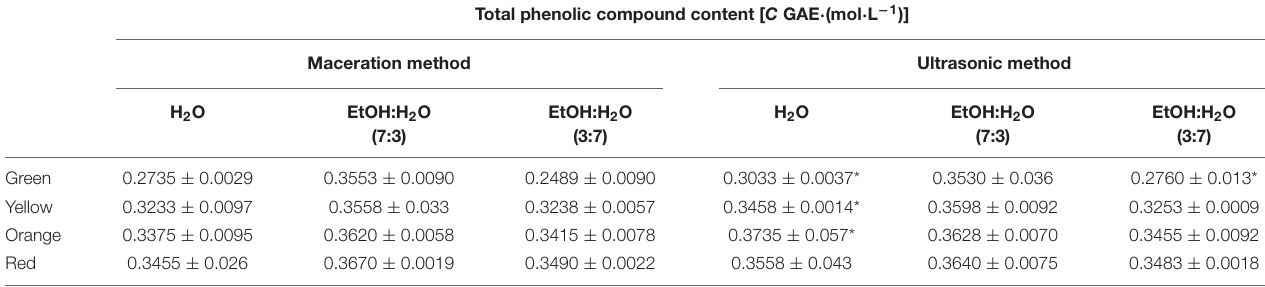
TABLE 3 | Total phenolic compound content (TPC) of the different A. unedo fruit extracts.